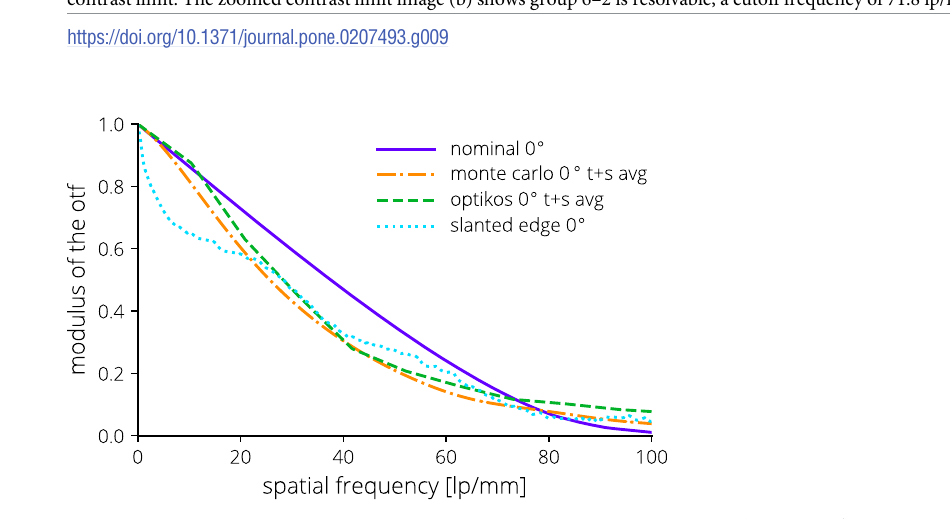
Fig 10. Comparison of the nominal, Monte Carlo, and measured on-axis MTF performance. The Monte Carlo analysis is an average system output. Measured MTF data is from an Optikos LensCheck instrument and from a slanted edge test. The sagittal and tangential data has been averaged where